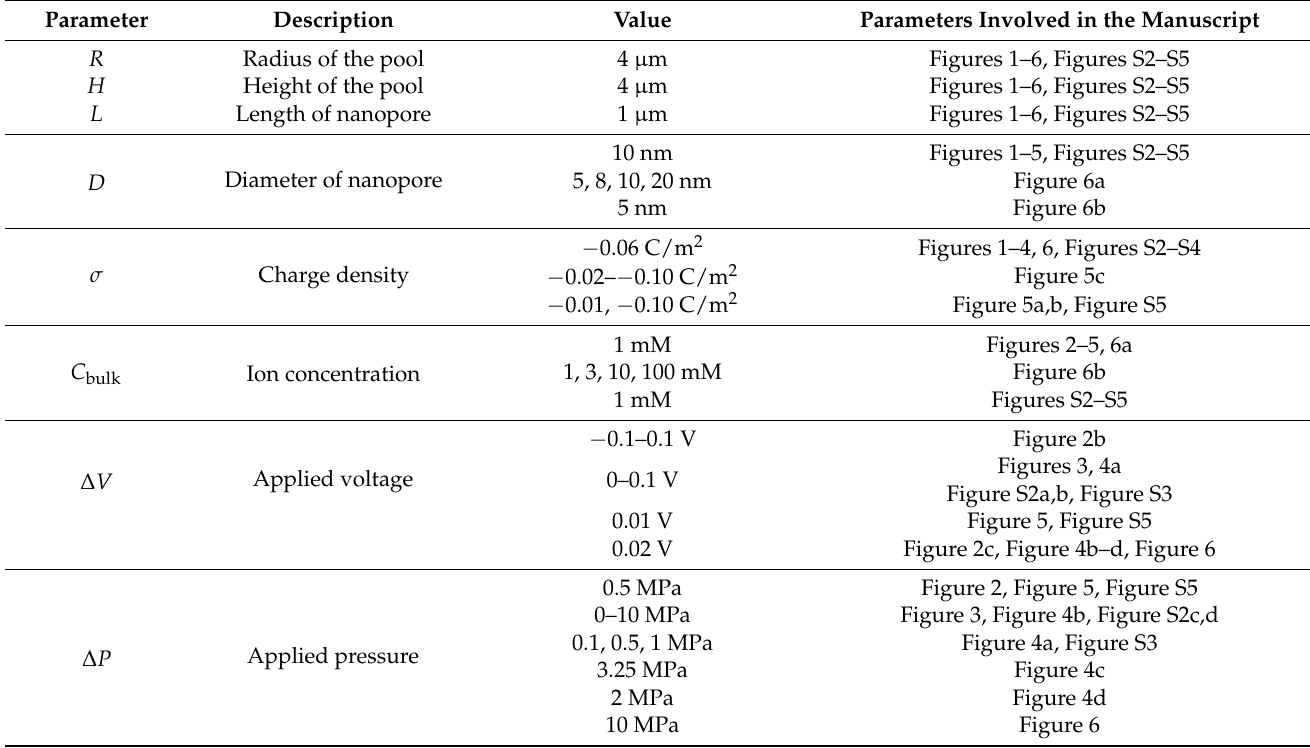
Figure 1. Calculation model and mesh analysis. ( a ) Schematic illustration of charged nanopore. ( b ) The grid in computational domain. Table 1. Parameters of calculation models.